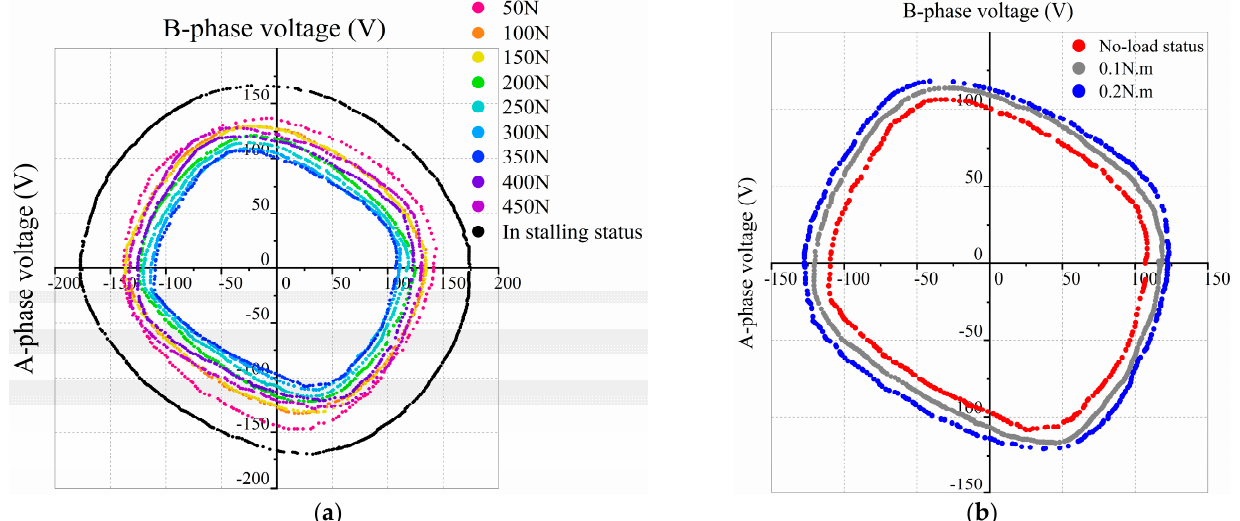
Figure 5. Variation of two-phase drive voltage with preload: ( a ) No-load status; ( b ) Different load states at a preload of 350 N.